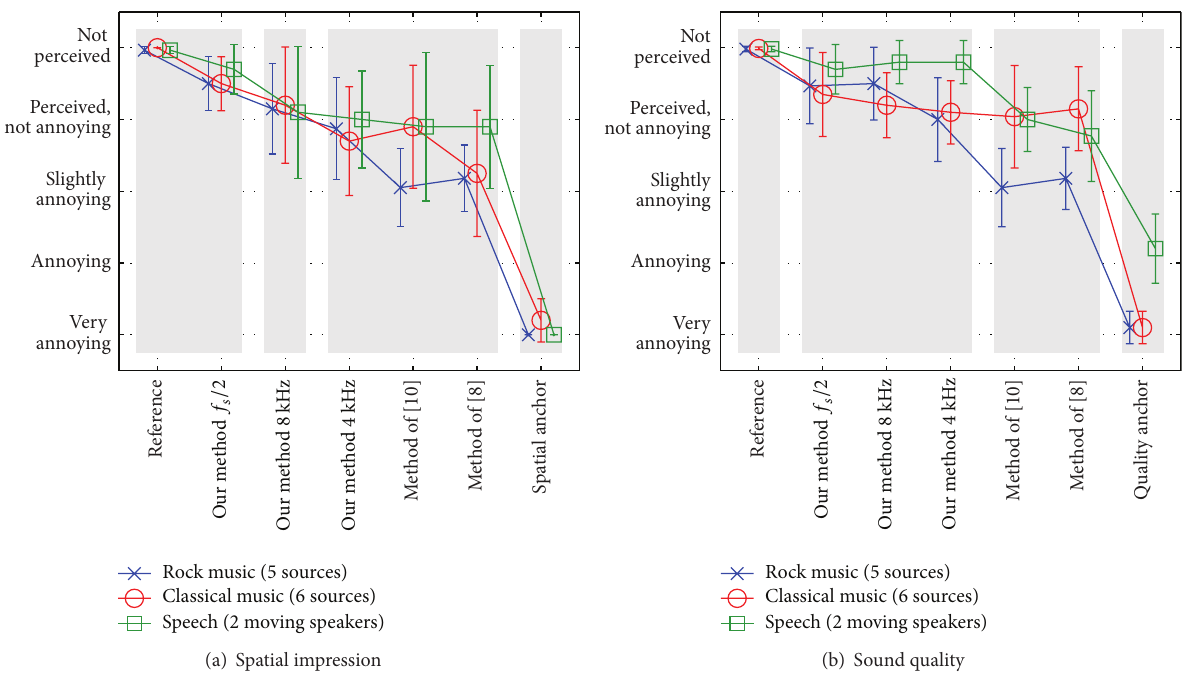
Figure 8: Listening test results for simulated recordings with loudspeaker